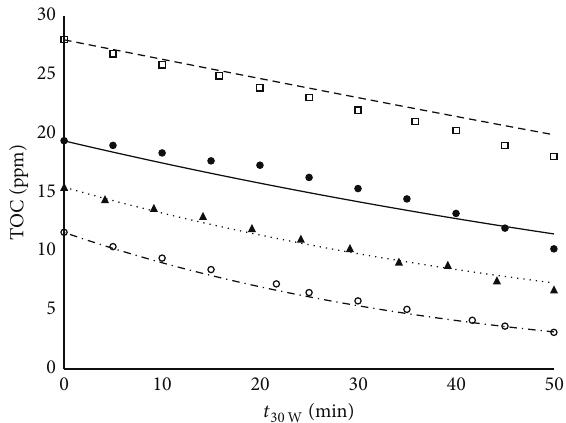
Figure 7: Solar mineralization of binary mixtures at 60 ppm.